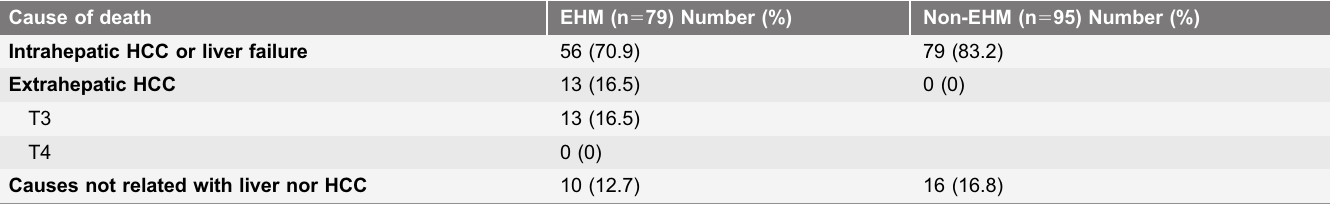
Table 4. Cause of death in advanced HCC patients with or without extrahepatic metastases. Cause of